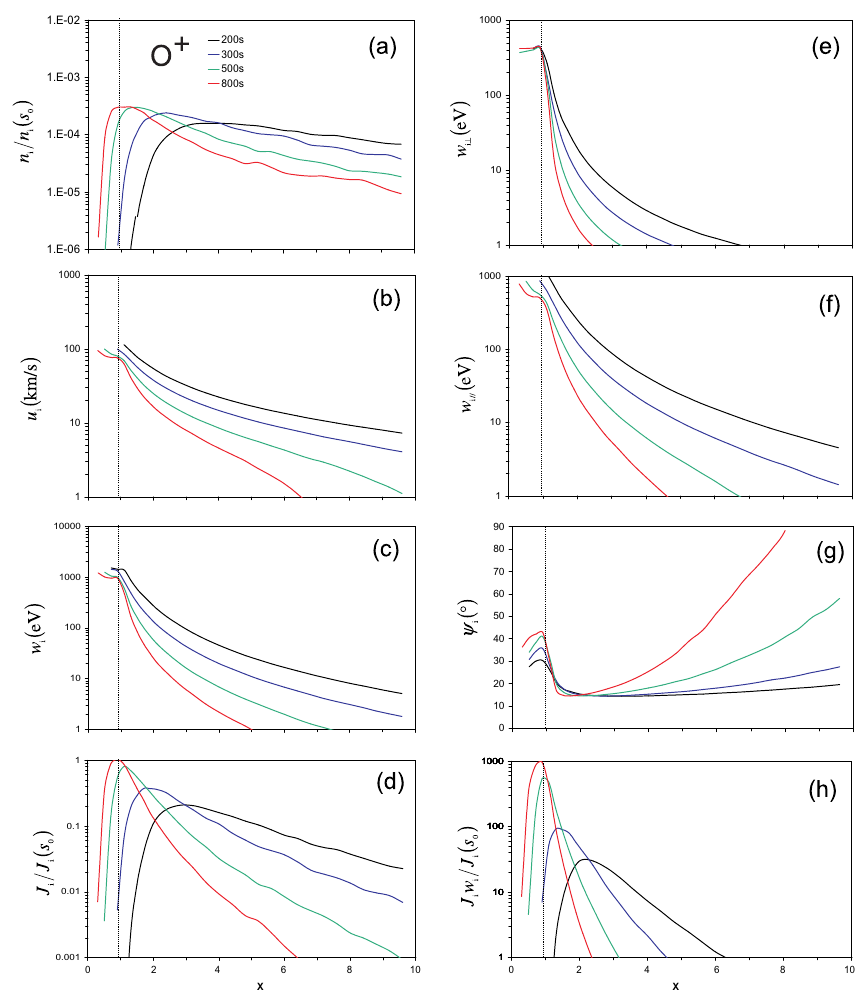
Fig. 9. Evolution of O + moments versus X at an altitude of 2 R E : ( a ) density, ( b ) upward mean velocity, ( c ) mean energy, ( d ) fluence, ( e ) perpendicular mean energy, ( f ) parallel mean energy, ( g ) apex, ( h ) energy density flux. The moments associated with panels (a), (d) and (h) are normalized with respect to the values at the low-altitude boundary. The colours are associated with different values of the residence time as listed in panel (a).